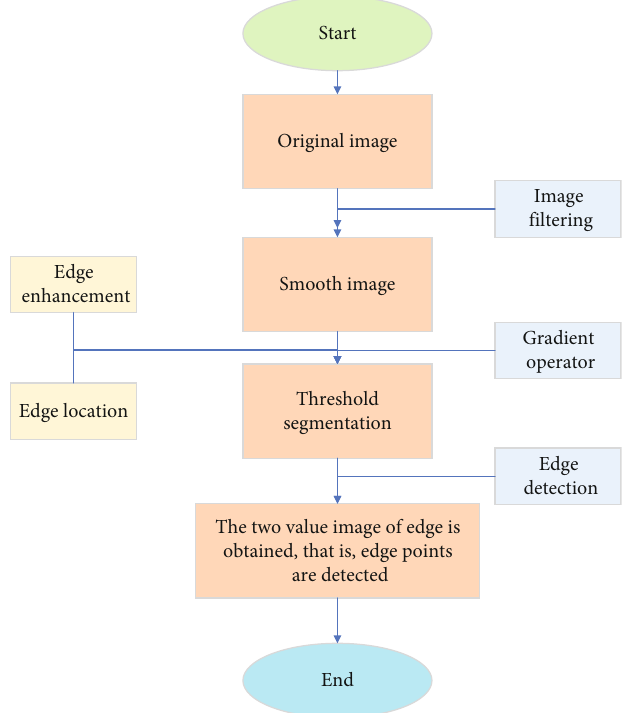
Figure 4: Art image edge detection noise processing fl